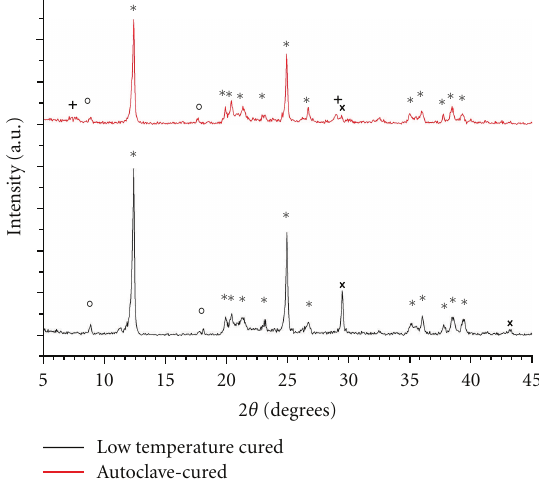
Figure 5: XRD di ff ratograms of samples cured at low temperature (25 ◦ C for 21 days) and in autoclave (180 ◦ C, 12atm for 10 hours). Detected phases are kaolinite ( ∗ ), halloysite ( ◦ ), calcite ( × ), and tobermorite